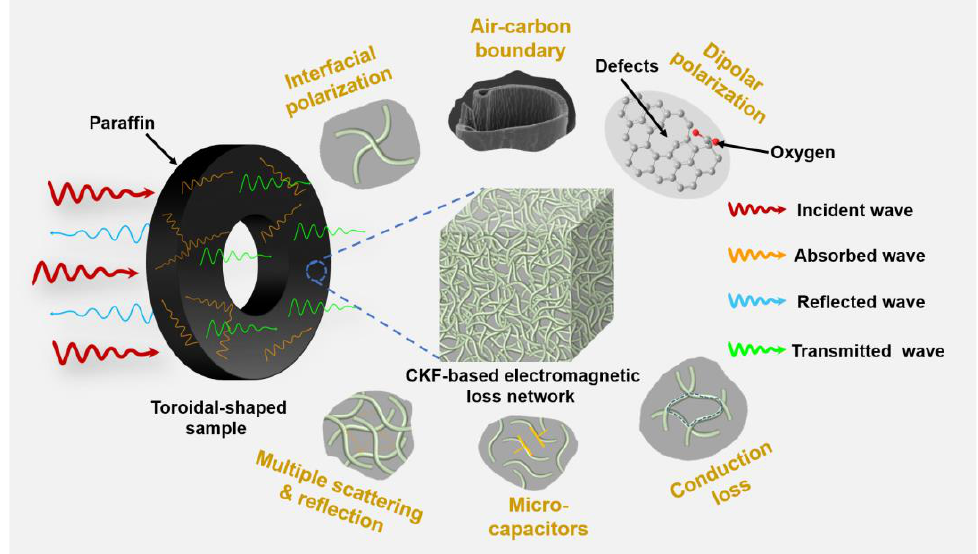
Figure 8. Schematic illustration of possible morphology-associated microwave attenuation for KF- derived carbon microtube. KF-derived carbon